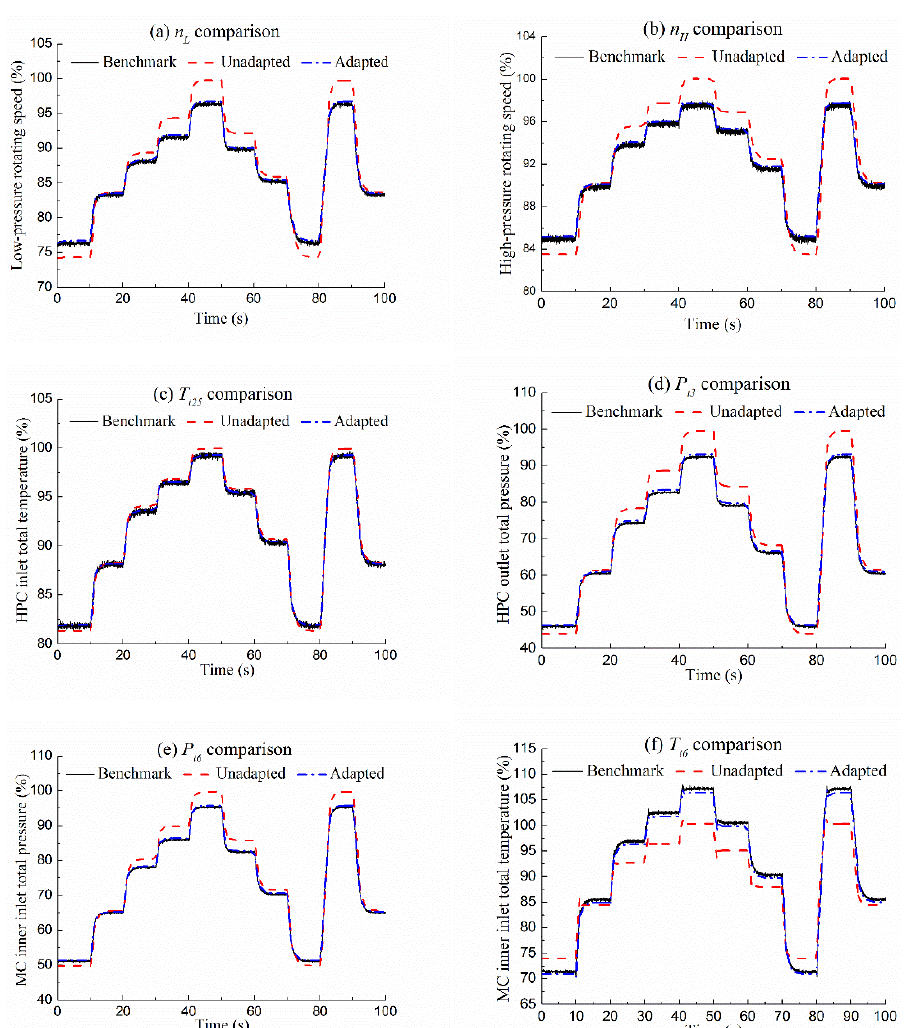
Figure 16. The prediction of the unadapted and adapted CLMs.